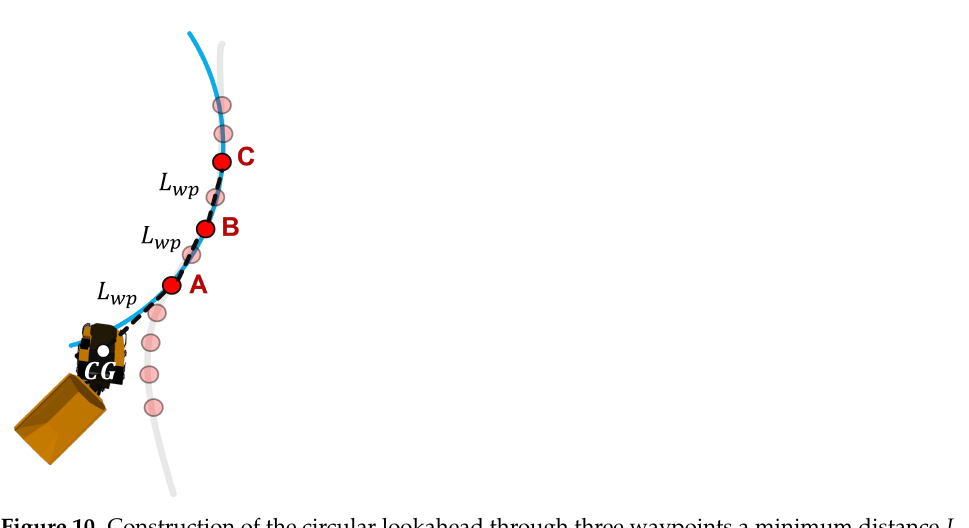
Figure 10. Construction of the circular lookahead through three waypoints a minimum distance L wp apart. The transparent waypoints represent the path and the highlighted waypoints represent the selected waypoints. The blue curve is the circle fitted through these